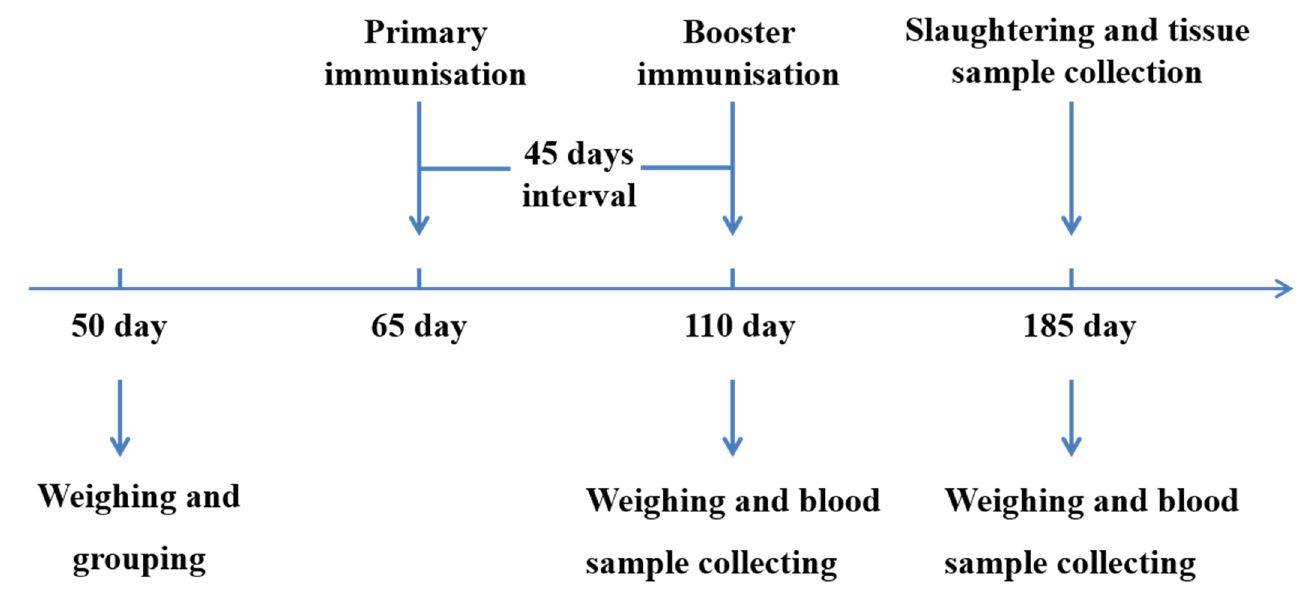
Figure 1. An outline explains the experimental design. Experimental pigs were immunised with SS DNA vaccine on days 65 and 110, and the control group was administered PBS. All pigs were slaughtered on days 185.